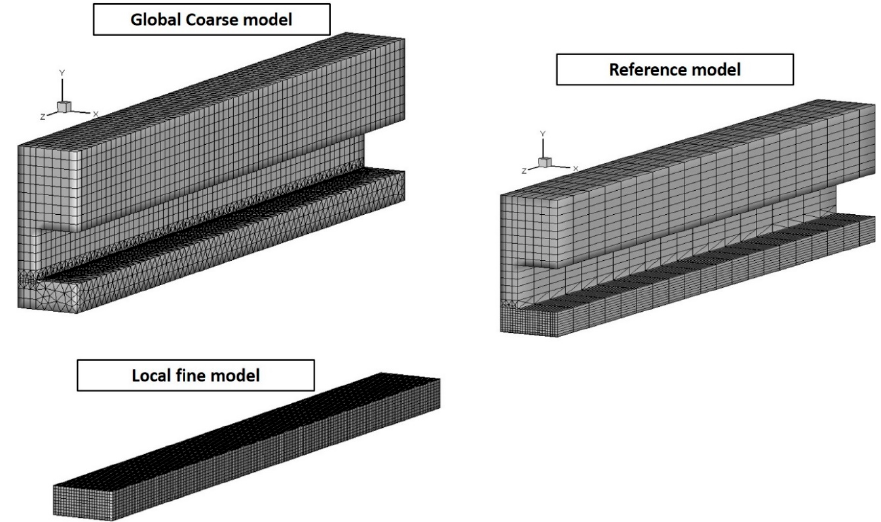
Figure 8. Three–dimensional Global, Local, and reference numerical models (the local model is “cut” at y = 0.9).